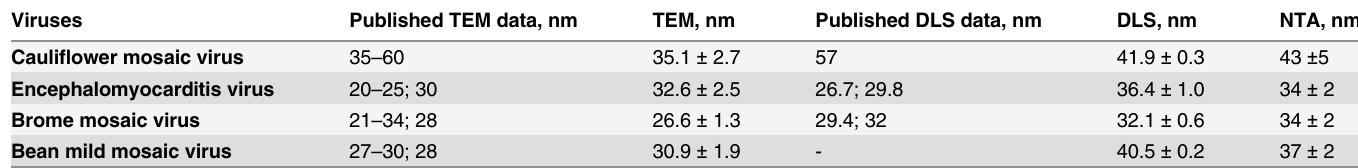
Table 1. Comparative characteristics of the virion sizes of icosahedral viruses using different techniques. Viruses